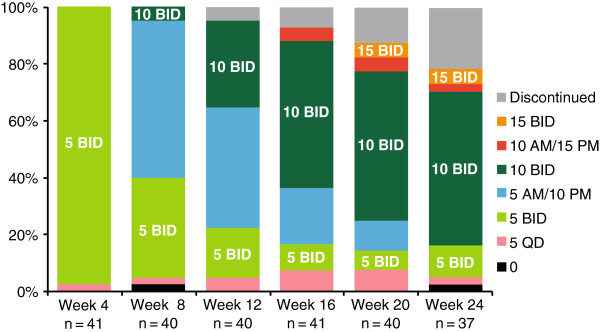
Distribution of ruxolitinib daily dose over the 24-week study period. N values represent patients with available dose information at the time of data analysis. Data shown for each time point represent the dose (in milligrams) that patients were receiving during the previous 4 weeks. BID, twice daily; QD, once daily.